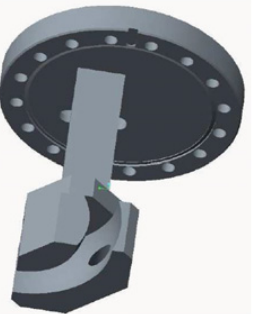
Figure 14. Pulsed electric deflector consisting of two spherically shaped insulated electrodes, one with a hole for the throughgoing beam.